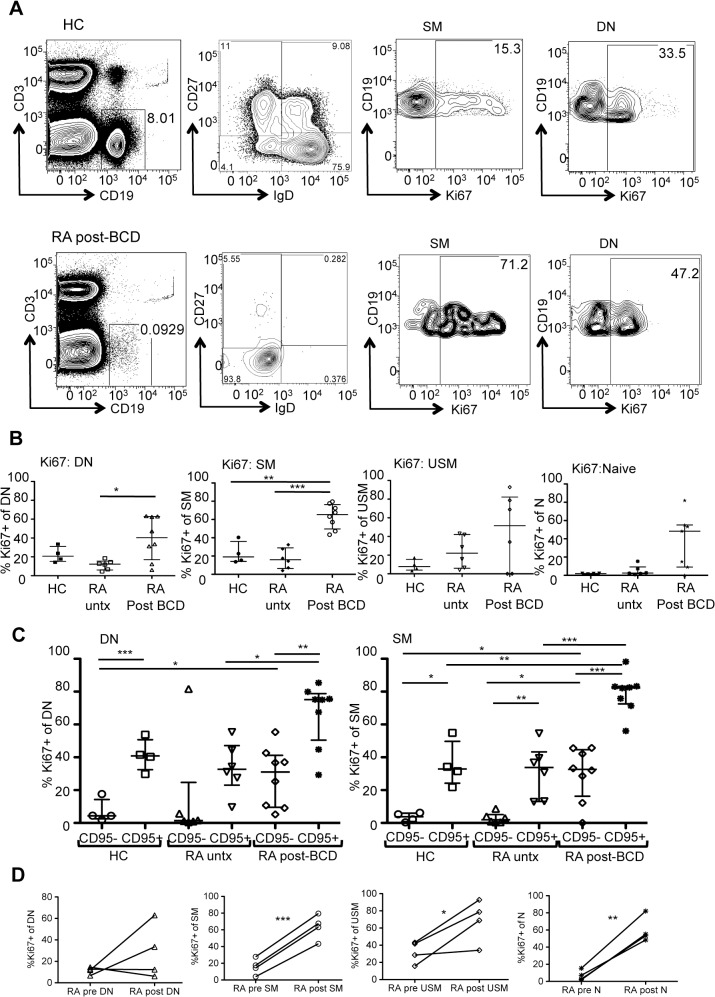
Residual memory B cells in RA following BCDT upregulate Ki67.(A) Dot plots show the expression of intracellular Ki67 (a proliferation antigen) in the gated SM and DN memory B cells. Dramatic up-regulation is seen in the RA patient after BCD compared to a healthy control. (B) Ki67 expression is significantly different in the DN and SM for RA post-BCD (n = 8) compared to untreated RA (n = 6) and healthy controls (n = 4) (*p<0.05, **p<0.005, ***p<0.0005) (Mann-Whitney) (3 group comparison DN p = 0.05, SM p = 0.0017) (Kruskal-Wallis). (C) CD95- B cells have very low expression of Ki67 in HC and untreated RA. Ki67 expression is higher in CD95+ B cells in the healthy controls in all 4 subsets (data not shown for Naïve and USM) (paired t-test). An increase in Ki67 expression is seen post-BCD in both the CD95+ and CD95- populations (*p<0.05, ***p<0.0005) (Mann-Whitney) (DN: 3 group comparison Kruskall-Wallis p = 0.0255 for CD95+ and p = 0.0420 for CD95-; SM: p = 0.0018 for CD95+ and p = 0.0284 for CD95-). The RA subjects post-BCD (n = 8) are B cell depleted (data not shown) and ranged from 3 to 6 months post-treatment. Data is expressed as the median +/- interquartile range. (D) Increase in Ki67 expression after BCD in matched samples (paired t test: *p<0.05, **p<0.005, ***p<0.0005). Post samples are 5 months after rituximab treatment.